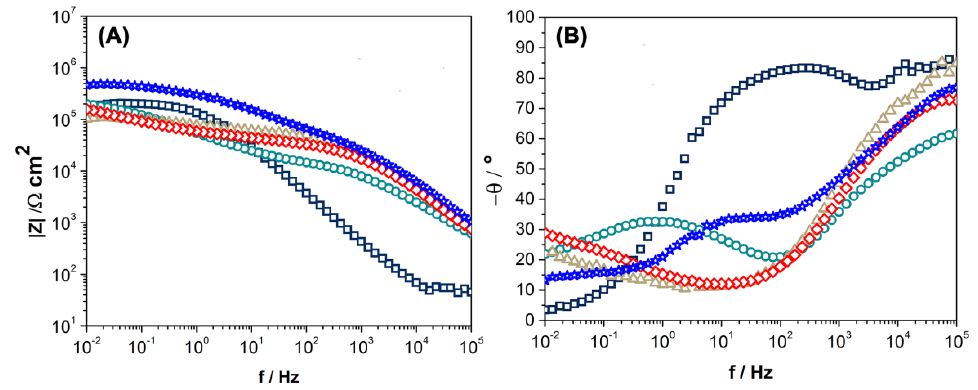
Figure 13. Bode diagrams of copper samples after different environmental exposure times were measured in a 0.1 M Na 2 SO 4 solution at E = OCP. ( A ) Modulus and ( B ) phase were corrected by the electrolyte. Exposure at 0 months (□), 3 months ( ○ ), 12 months ( △ ), 24 months ( ◇ ), and 36 months ( ☆ ).